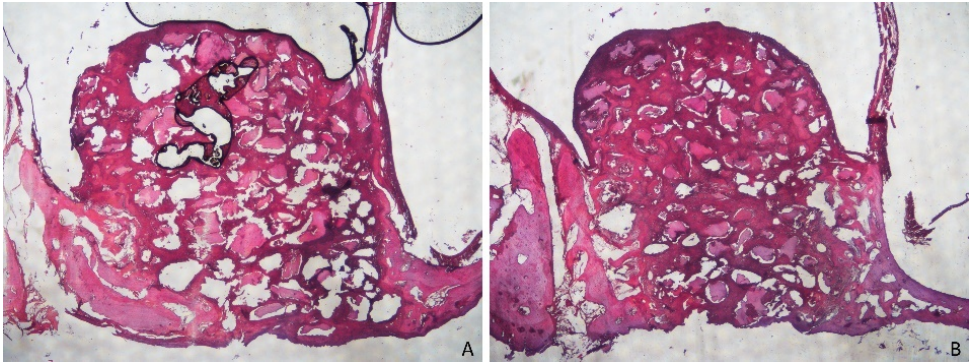
Figure 7. ( A ) Merged images from photomicrographs of sections of decalcified samples representing the healing after 4 weeks in membrane group. Scarlet-acid fuchsine and toluidine blue. ( B ) Merged images from photomicrographs of sections of decalcified samples representing the healing after 4 weeks in non-membrane group. Scarlet-acid fuchsine and toluidine